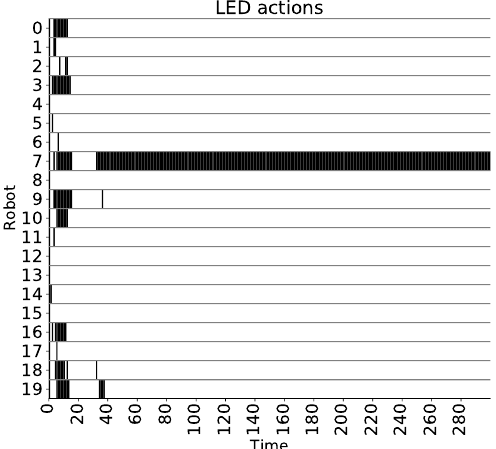
Figure 4. LED actions of the robots in a swarm of size 20 as time elapses in the leader selection experiment. Horizontal black bars denote that the LED is activated. Two phases, namely, negotiation and leader settlement, are